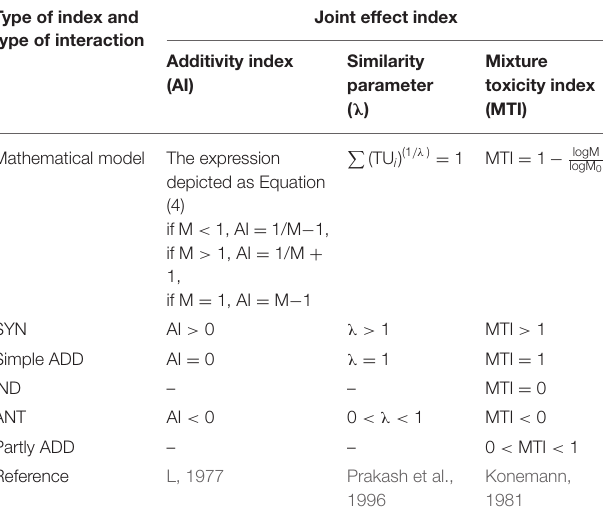
TABLE 2 | Criteria for the judgment of joint effects of different evaluation